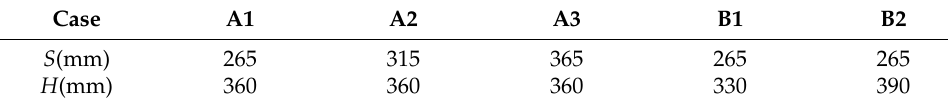
Table 4. Five studied cases of tundish water model experiment.